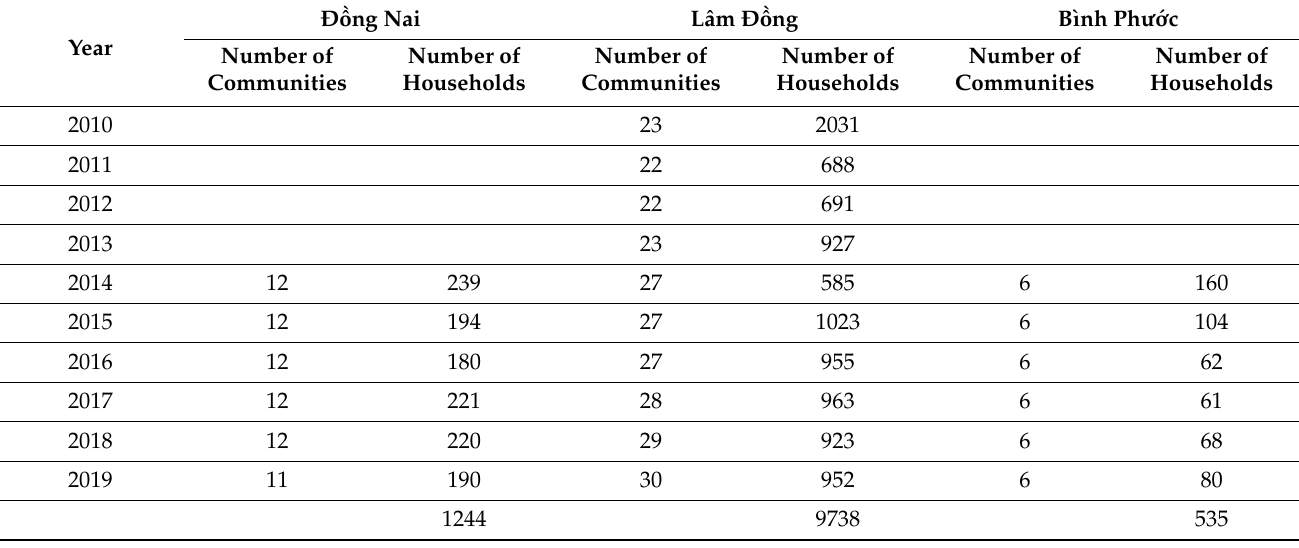
Figure 6. Numbers of communities and households contracted to protect forests in CTNP. Source: Cat Tien National Park. Table 7. Numbers of communities and households participating in PFES by province.